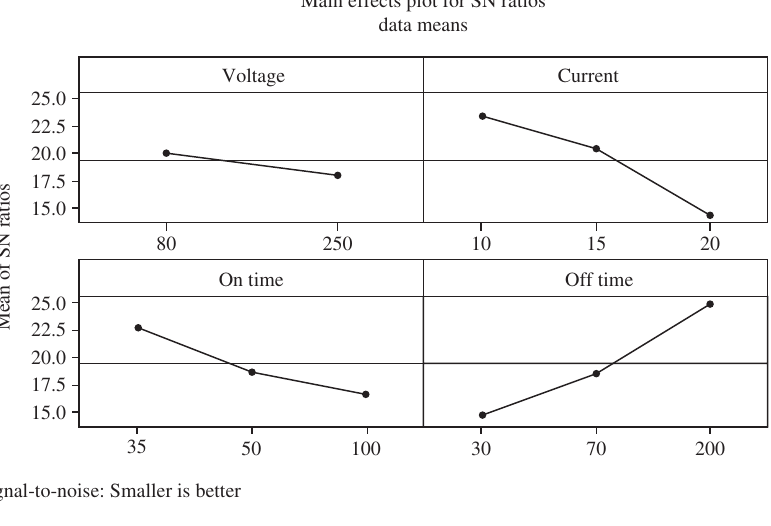
Figure 6: Effects of the input parameters of EDM on TWR in the machining of 2024 alloy.